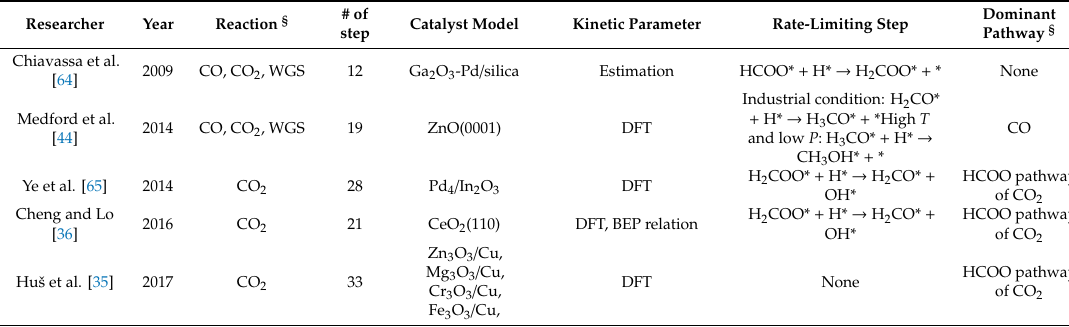
Table 3. Previous microkinetic studies for MeOH synthesis on various